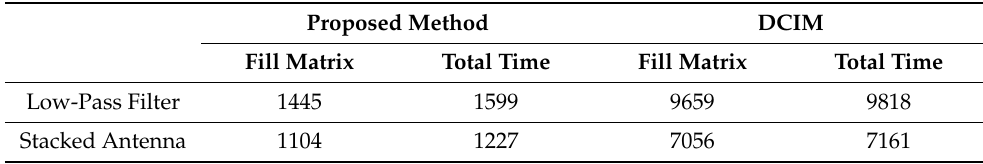
Table 3. Calculation CPU Time (s) for different planar structures using